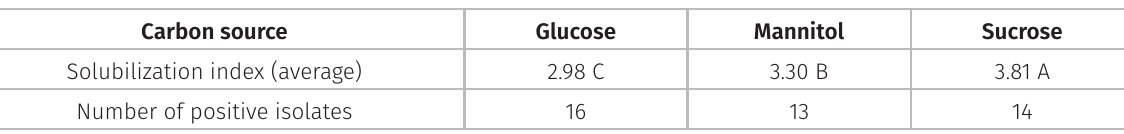
Means followed by the same letter do not differ by Tukey test at 5%